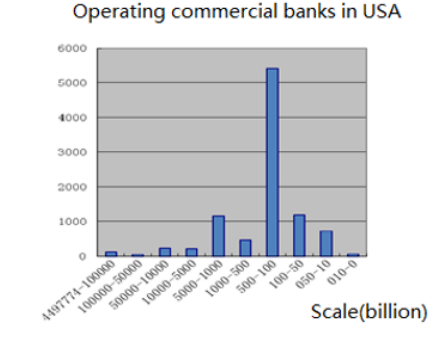
Fig. 2. Asset distribution frequency of operating banks in the USA in